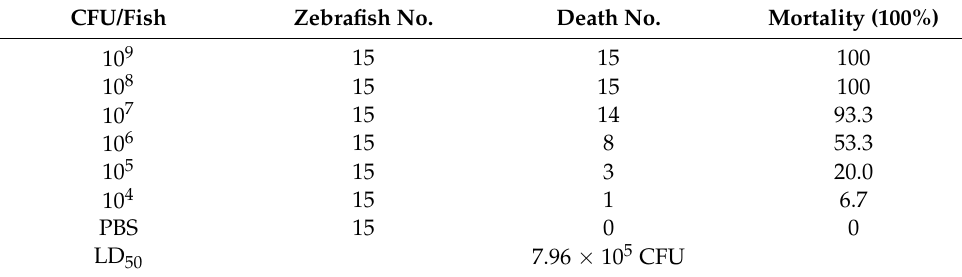
Table 4. LD 50 of the zebrafish after challenged by SS9. CFU/Fish Zebrafish No. Death No.